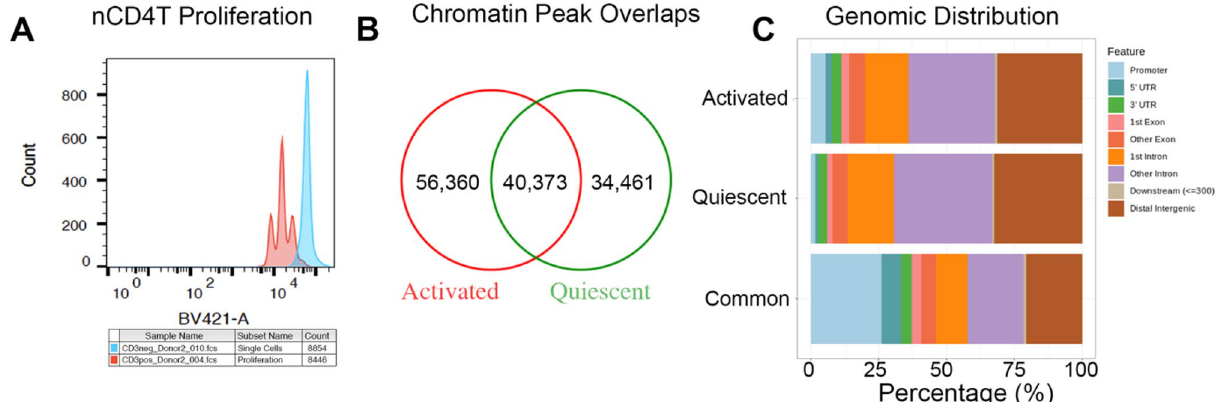
Figure 1. Activation of nCD4T induces widespread changes in chromatin accessibility. (A) nCD4T stained with CellTrace Violet and stimulated in culture for 3 days. Discreet peaks represent successive generations of live cells. The unstimulated parent generation is show in blue. (B) Venn diagram showing counts of chromatin accessibility peaks. (C) Annotation of consensus chromatin accessibility peaks to genomic regions of the hg38